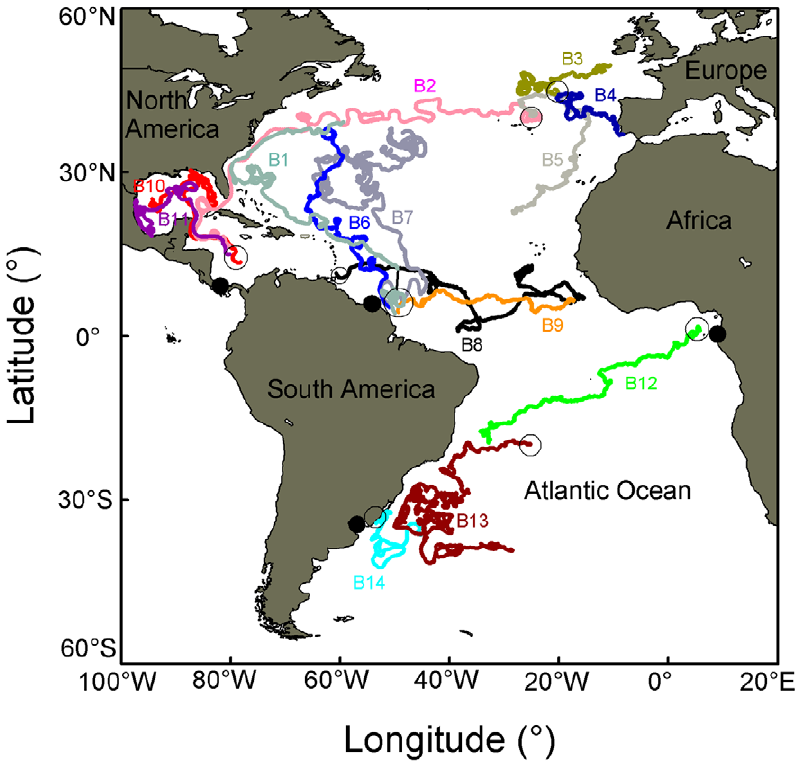
Figure 3. Trajectories for satellite-tracked drifters. Map of trajectories for satellite-tracked drifters released in the vicinity of leatherback turtle tagging sites. Filled circles show the location of the tagging sites. Dotted circles show the starting point of the drifter tracks. Drifters were selected to indicate possible drift scenarios from the tagging sites (Panama, Suriname, French Guiana, Gabon and International waters off the Uruguayan coasts) to the main Temporary Residence Areas of the leatherback turtles identified in this study.